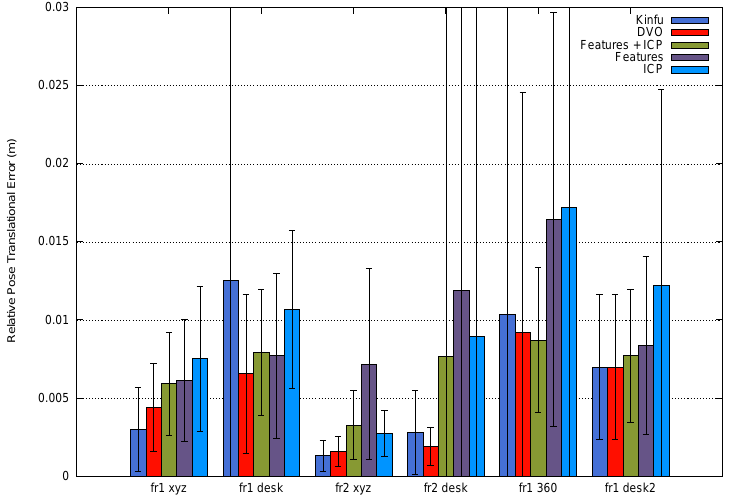
Figure 12. Error means (bars) and the standard deviations (error lines) of the five different methods applied to the selected datasets.